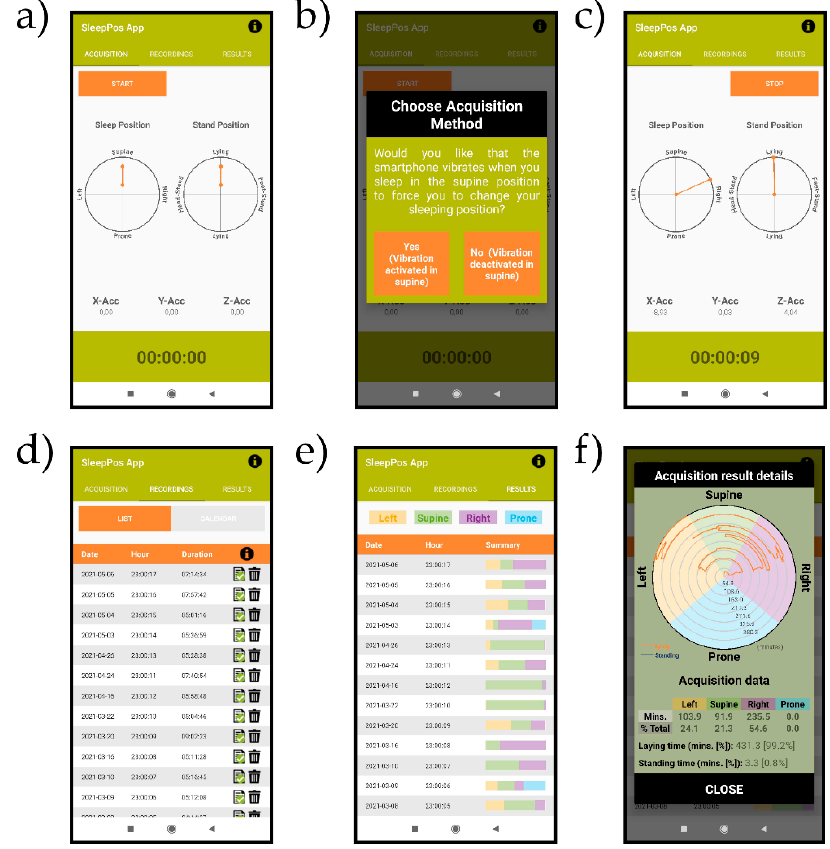
Figure 3. Screenshots of the ‘SleepPos’ app. The ‘Acquisition’ tab ( a ) is used to record the sleep position. Upon clicking the ‘Start’ button, a dialog is prompted ( b ) asking if positional treatment should be applied. Afterwards, the sleep position is acquired and displayed ( c ) on the polar plots as well as the accelerometry values and the time spent on the acquisition. The ‘Recordings’ tab ( d ) shows the details of each acquisition, which include the date, hour of start, and duration. The ‘Results’ tab ( e ) shows a summary of the sleep position for each acquisition. When clicking over each summary, a window prompts ( f ) showing the sleep position with angular resolution, as well as a table with the summarized details of the acquisition.